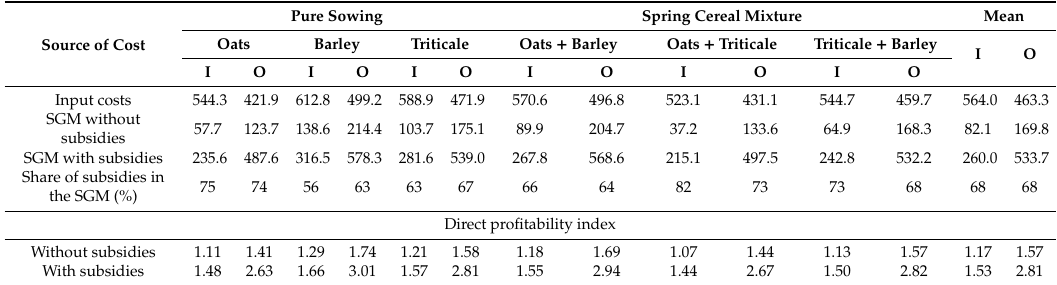
Table 10. Economic indicators of pure and mixed sowings of spring cereals in integrated or organic crop rotations (EUR ha − 1 ); prices for the year